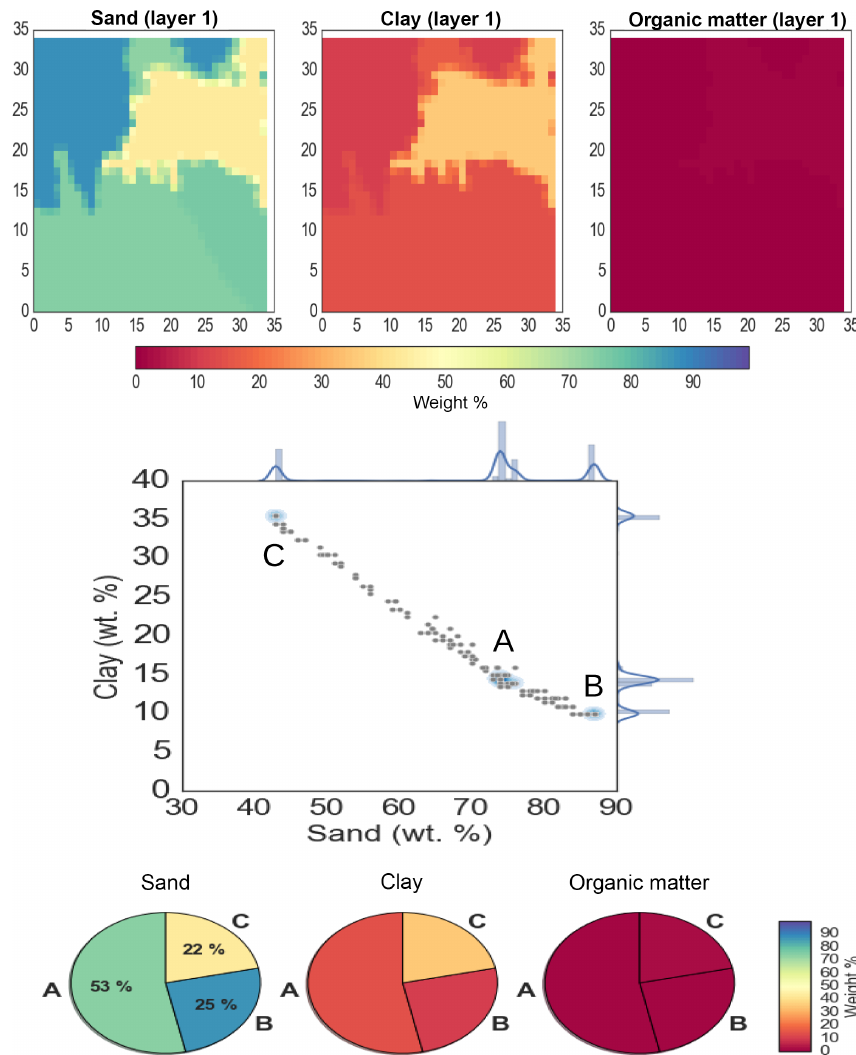
Figure 3. Similar to Fig. 2 for a CLASS-CTEM grid cell located in Brazil (9.8 ◦ S, 45.0 ◦